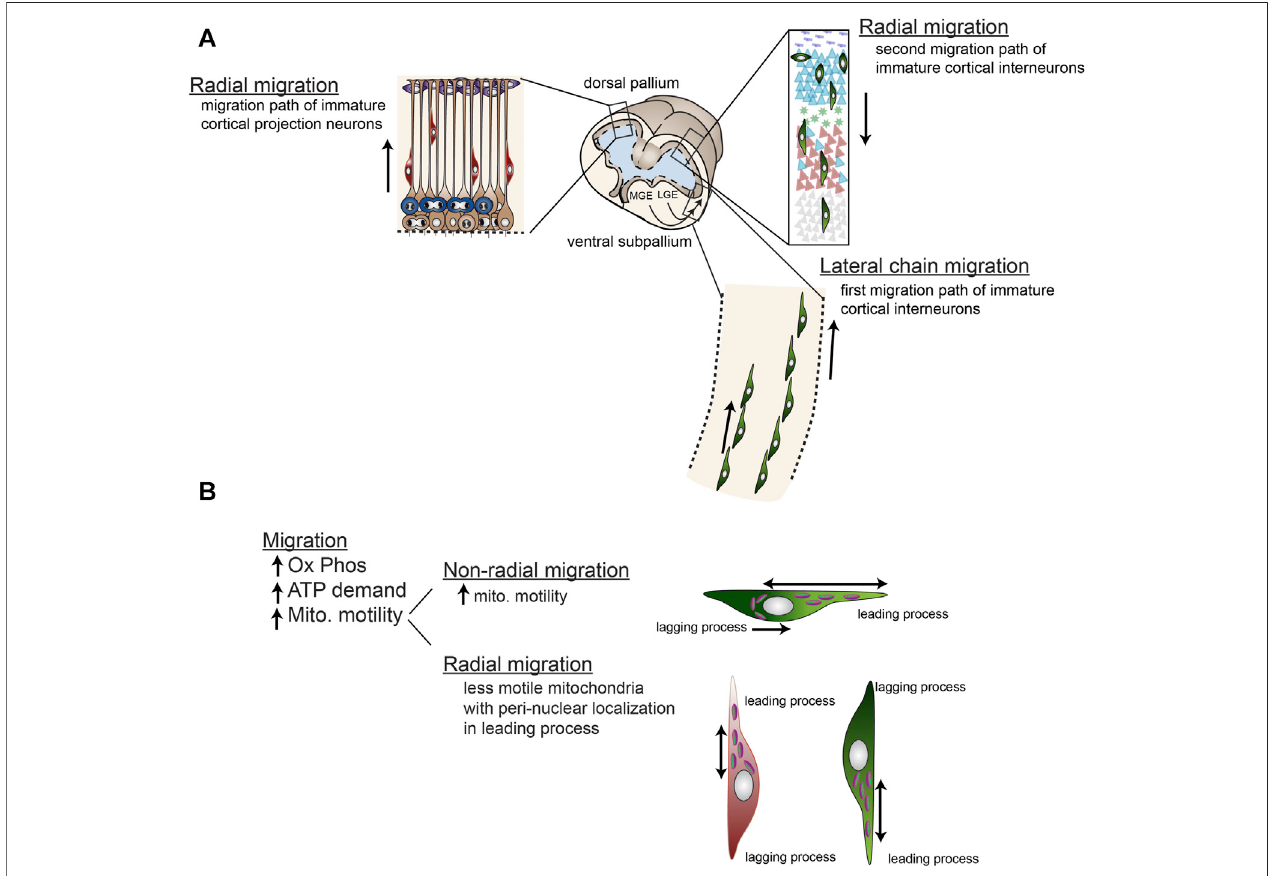
FIGURE 7 | Radial and non-radial migration of immature cortical neurons involve differential mitochondrial mobility. (A) Cortical projection neurons are generated from dorsal (pallial) progenitors and migrate radially along radial glial processes to their location in the developing cortical plate. Early born projection neurons inhabit deeper layers and later-born neurons inhabit more super fi cial layers generating the cortex in an “ inside-out ” fashion. Cortical inter neurons are generated in the ventral ganglionic eminences including the lateral ganglionic eminence (LGE), medial ganglionic eminence (MGE), and caudal ganglionic eminence (CGE, not shown). Theseneuronsthenmigratenon-radially via chainmigrationintothecorticalplate,thenmigrateradiallyalongradialglial fi bersdownintothecorticallayers.Likeprojection neurons, early born interneurons inhabit deeper layers and later-born neurons inhabit more super fi cial layers. (B) Mitochondria are relatively immobile during radial migrationresidingclosetothenucleusontheleadingedgeofthecellbody,whilemitochondriainnon-radiallymigratingneuronsarehighlymobilethroughouttheleading process and also localized on the lagging edge of the nucleus during retraction of the lagging process. Generally, migration requires high levels of ATP from oxidative phosphorylation.